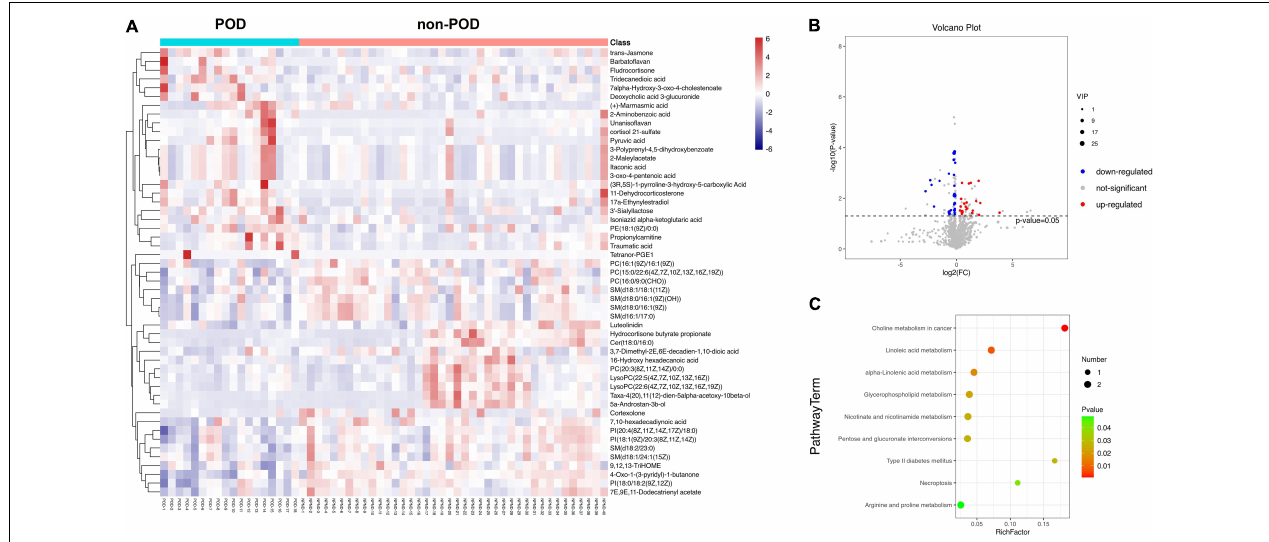
FIGURE 3 | (A) A heatmap showed the 51 differentially expressed metabolites (DEMs, P < 0.05; variable influence on projection > 1) between POD and non-POD patients after cardiac surgery. The color, ranging from blue to red, indicated that the expression abundance of metabolites ranged from low to high; that is, red indicated a higher expression abundance of different metabolites. (B) Volcano plot represented the 51 DEMs when compared between POD and non-POD groups. Compared with non-POD group, blue dots represent down-regulated metabolites and red dots represent up-regulated metabolites in POD group. (C) The 51 differentially expressed metabolites were subjected to Kyoto Encyclopedia of Genes and Genomes (KEGG) pathway enrichment analyses, and the bubble diagram showed a total of nine significantly different pathways ( P < 0.05).